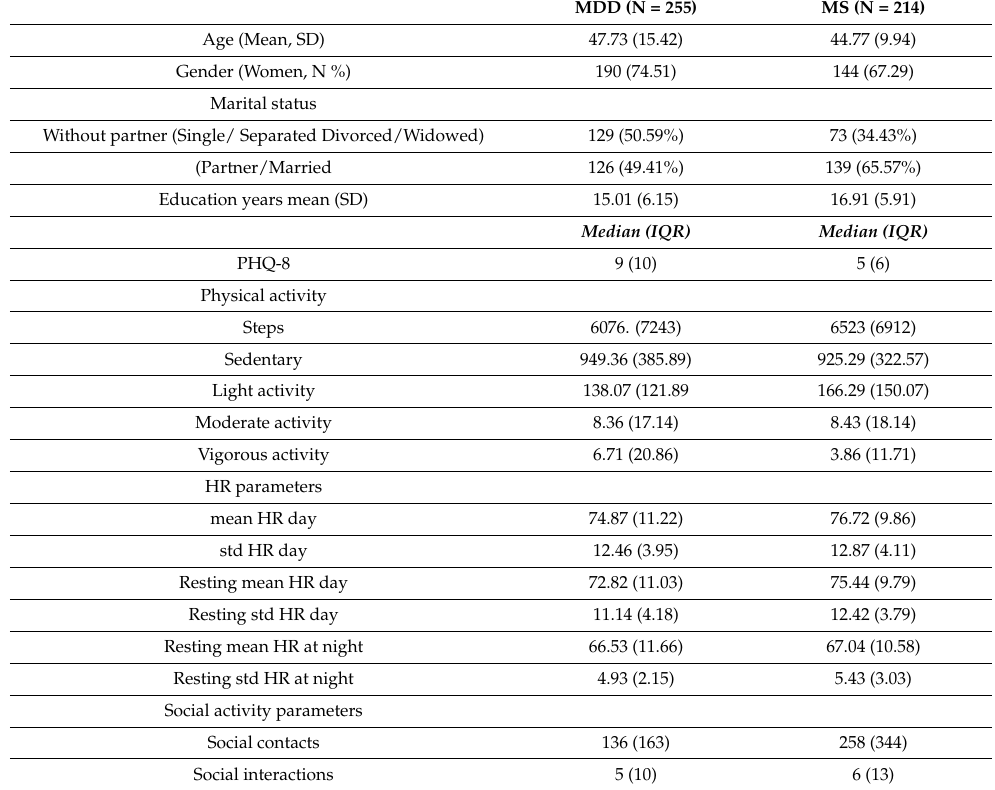
Table 2. Sample and feature